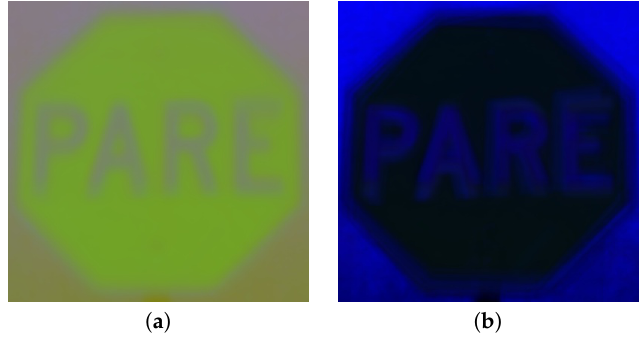
Figure 9. Scaled images of the mean µ Y ( a ) and standard deviation σ Y ( b ) of the Y channel.